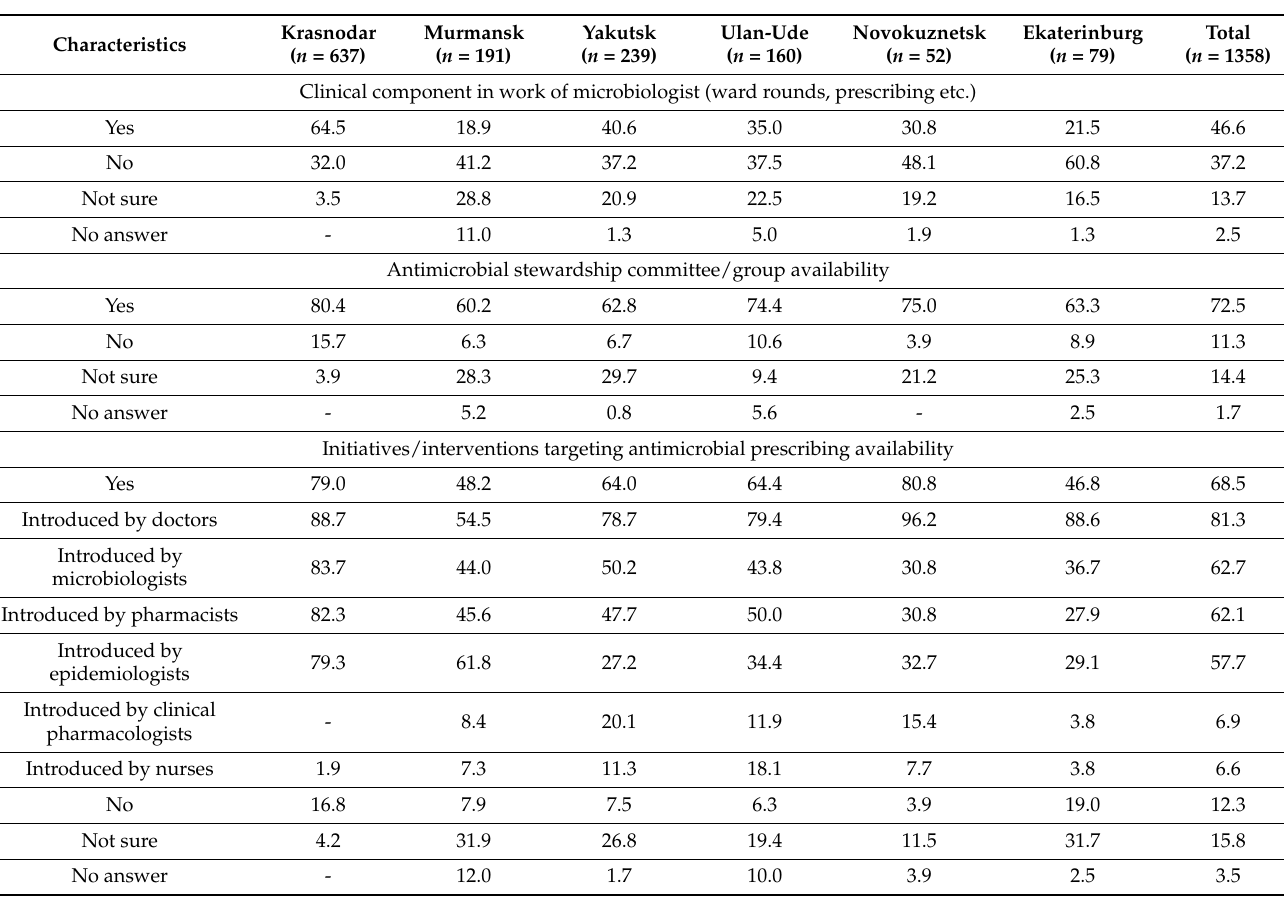
Table 4. Role of microbiologists and antimicrobial stewardship programs implementation in institution/organization, %.